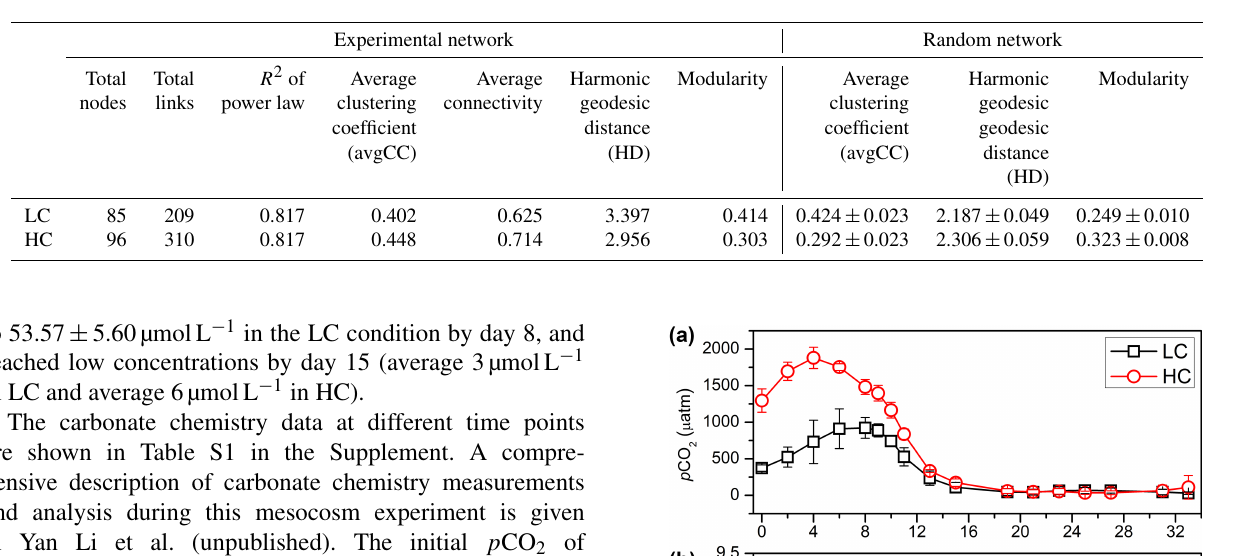
Table 1. Topological properties of the bacterioplankton communities as represented by molecular networks under HC and LC treatments, as well as their rewired random networks.